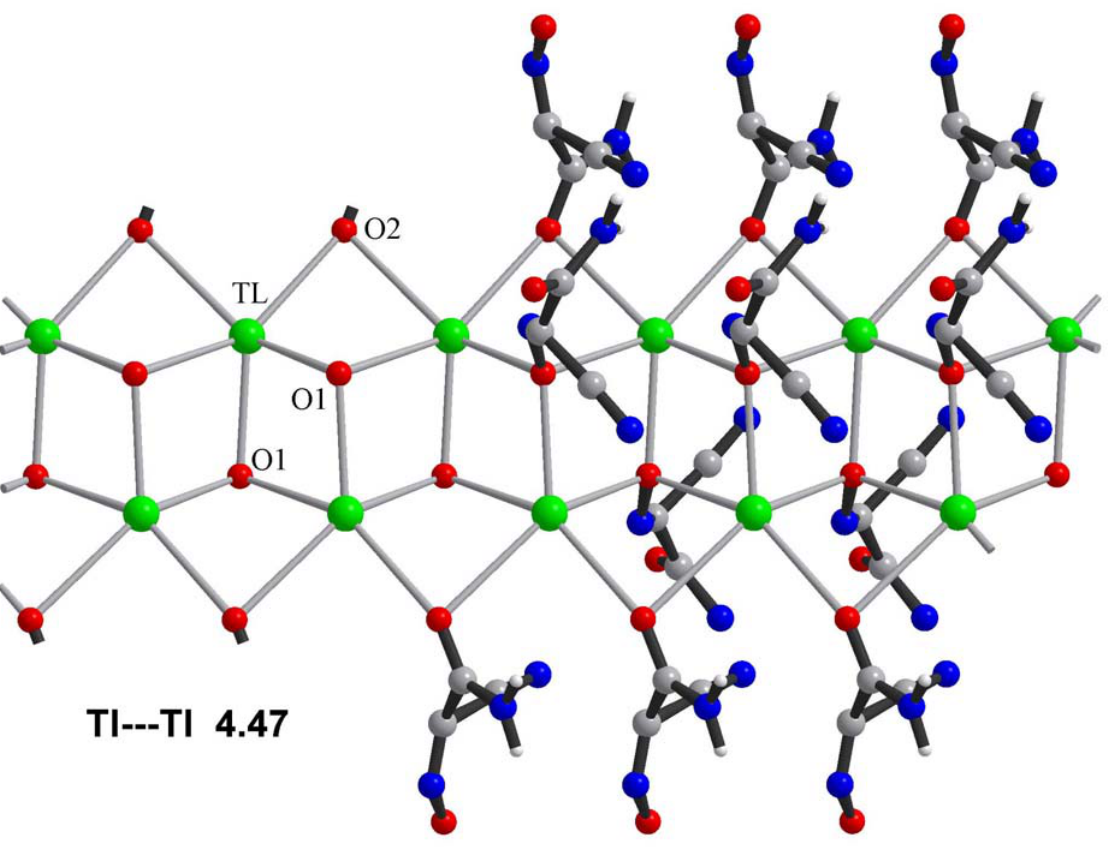
Figure 7. Organization of a double-stranded, ladder-type 2D sheets in this 3D-coordination polymeric structure of